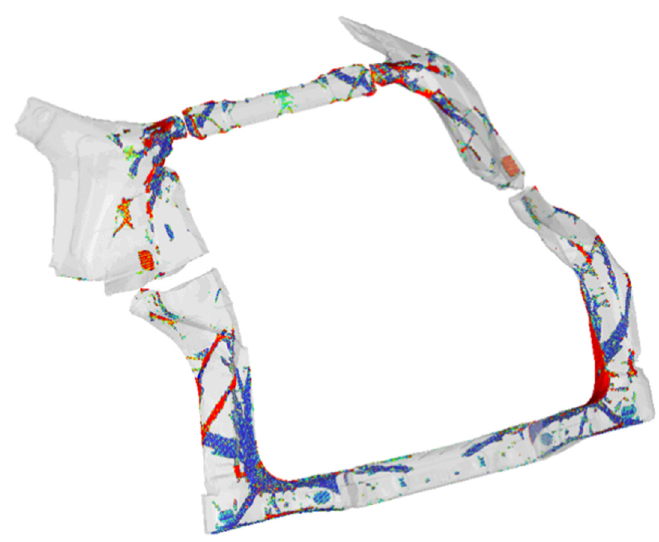
Figure 17. Complete new rear part of the vehicle with highlight of the reticular internal structure resulting from optimization.